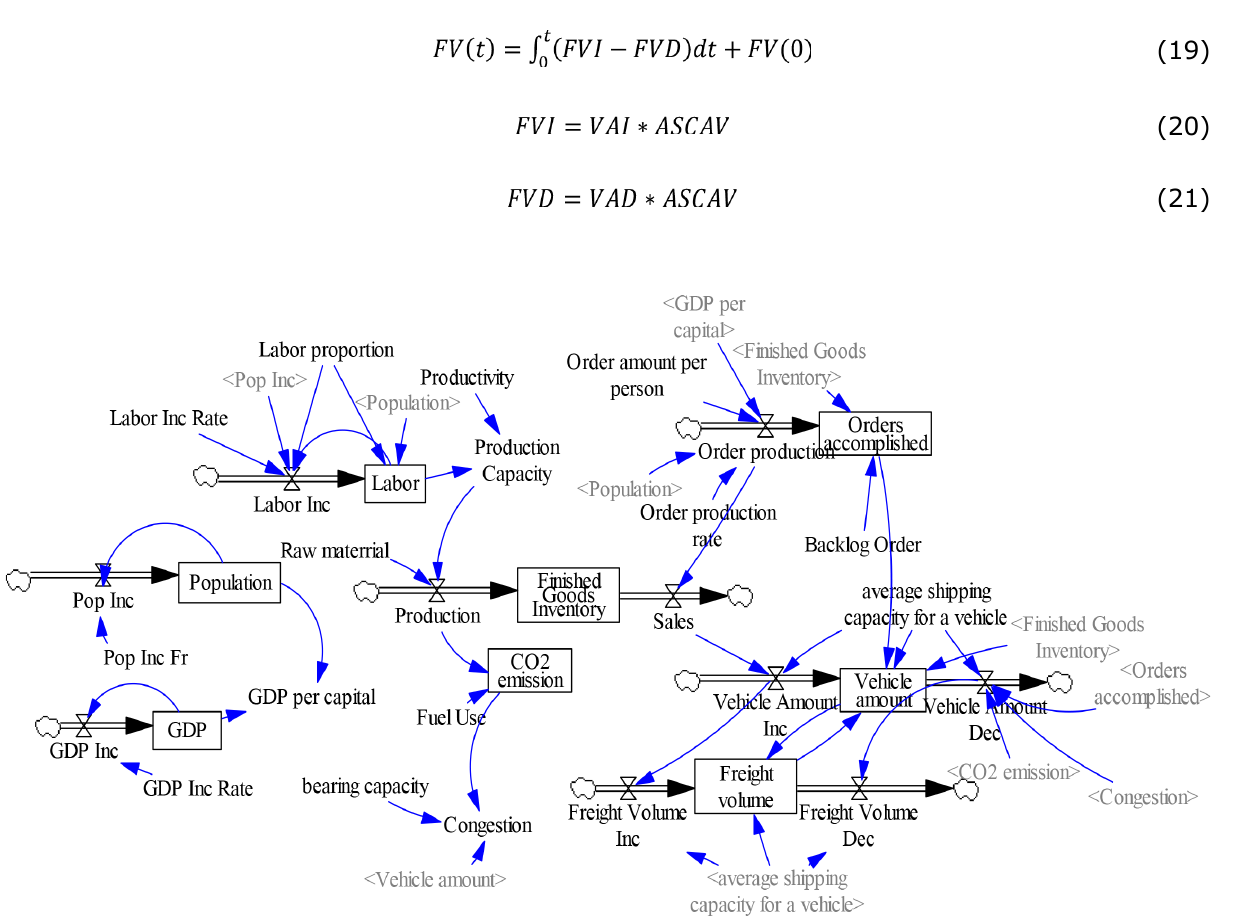
Figure 4. Stock and flow diagram of SD